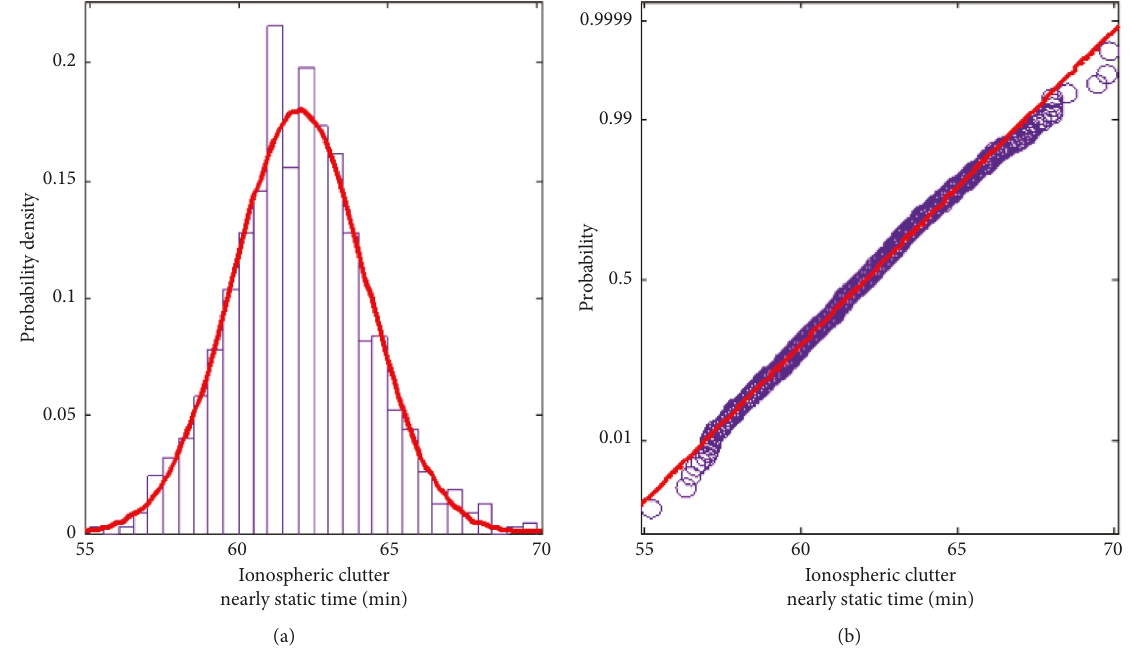
Figure 5: Normality test of ionospheric clutter nearly static time. (a) Density of ionospheric clutter nearly static time. (b) Probability of ionospheric clutter nearly static